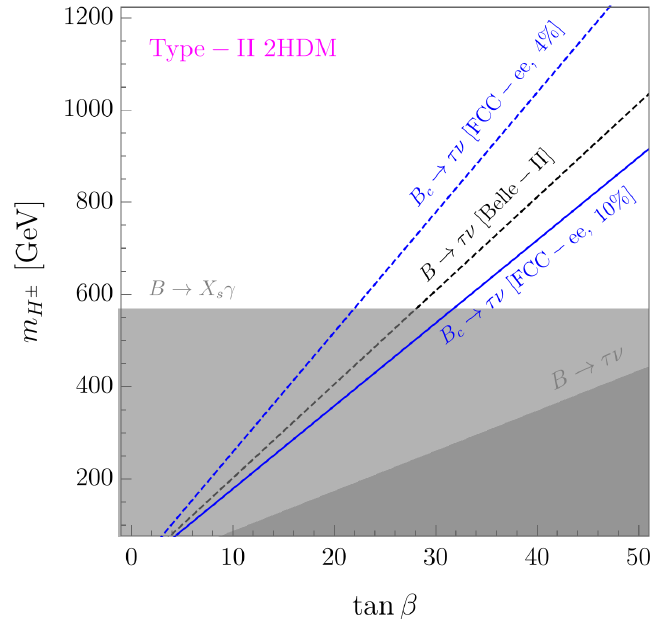
for type-II 2HDM derived by assuming Figure 9 . Expected constraints on the plane tan β vs. m H ± a relative uncertainty on Γ( B + → τ + ν τ ) / | V cb | 2 of 10% (solid blue line) and 4% (dashed blue line). c Current constraints obtained from B ( B → X ) [66] and B ( B + → τ + ν ) [61] are depicted by the s γ τ grey regions. Prospects for a B ( B + → τ + ν ) measurement at Belle-II are depicted by the grey τ dashed line, obtained under the assumption of 5% uncertainty on the branching fraction